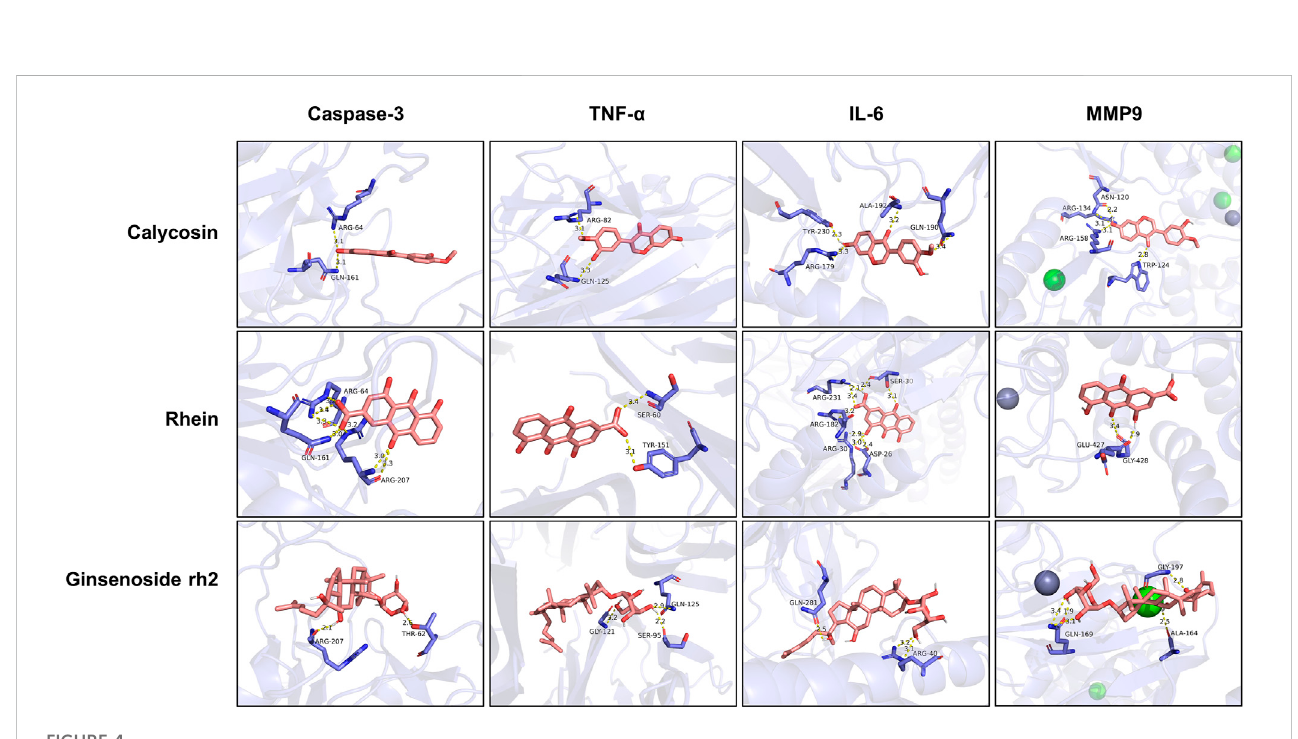
FIGURE 4 The molecular docking results between active ingredients and hub